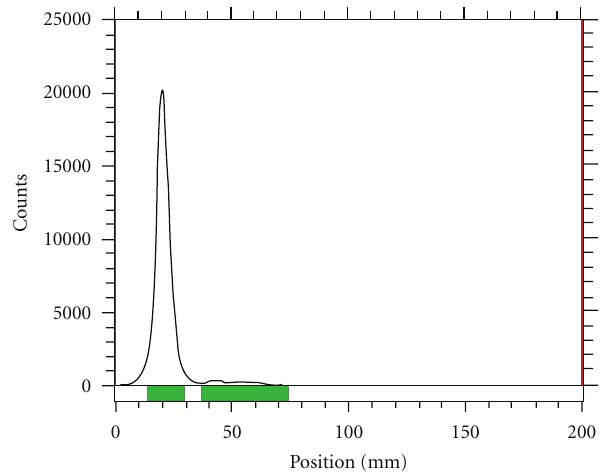
Figure 1: Radiochemical purity of 131I-SHH was > 95%. Radio- chemical purity was determined by radio TCL with normal saline as the mobile